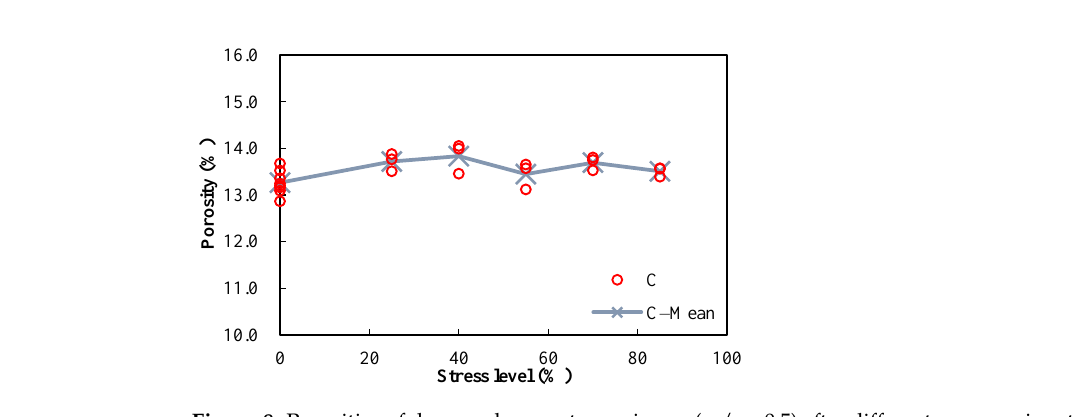
Figure 7. Porosities of damaged mortar specimens (w/c = 0.5) after different compressive stress lev- els.